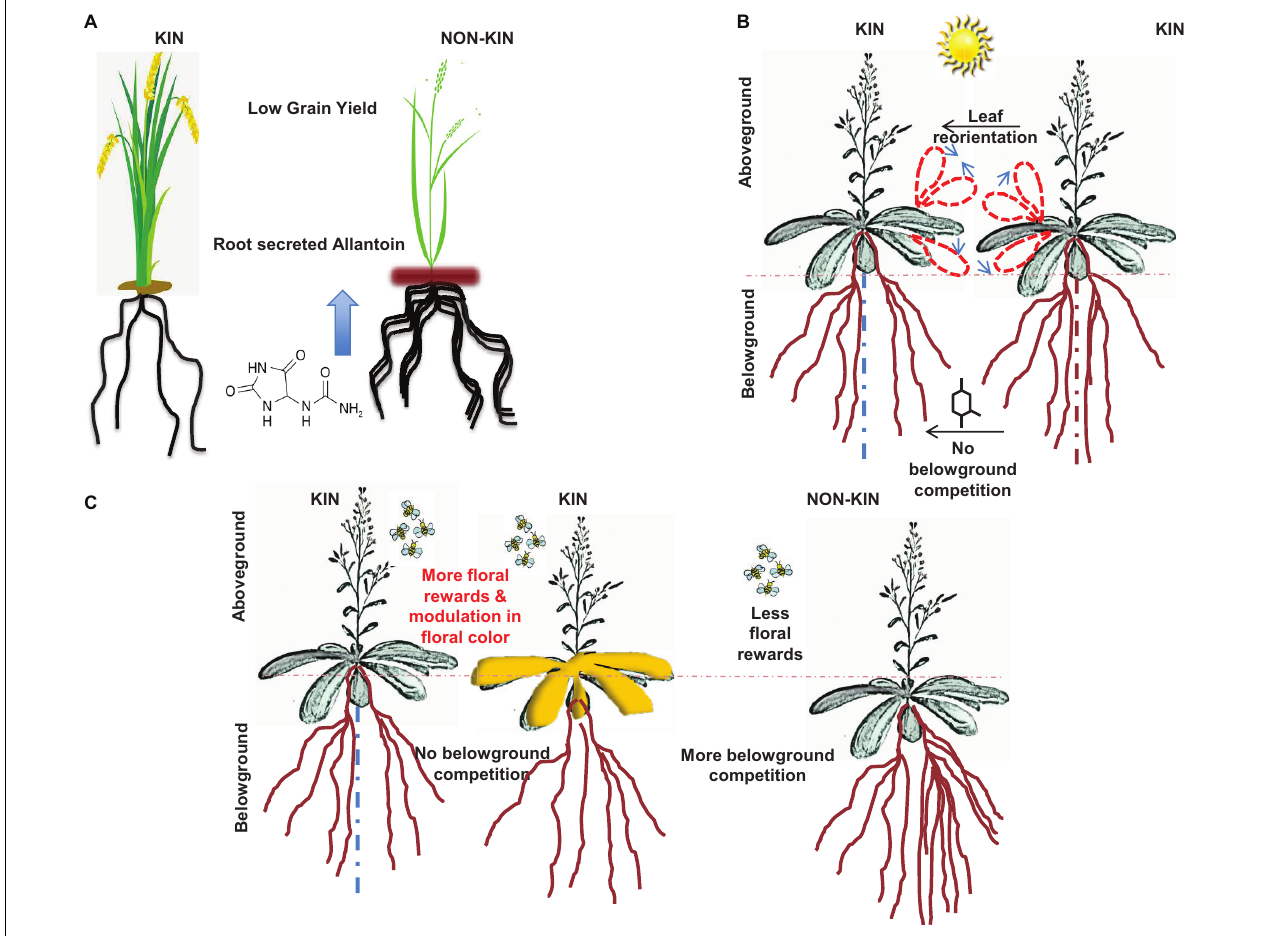
FIGURE 1 | The schematic shown depicts variation in kin recognition and discrimination in plants with different trade-offs. (A) The image in panel A is adapted from Bais (2018), rice plants exposed to kin members secrete less allelochemical (allantoin) compared to interactions with non-kins (Yang et al., 2018). (B) Panel B shows aboveground trade-offs of kin recognition in Arabidopsis plants. The schematic is adapted from Bais (2015), wherein kin plants interactions with other kin showed reorientation of leaves (more light sharing) and less root allocation (Crepy and Casal, 2014). (C) Panel C is also adapted from Bais (2015), in here, plants reacting with kin showed more floral reward system compared to its interaction with non-kin members (Torices et al.,